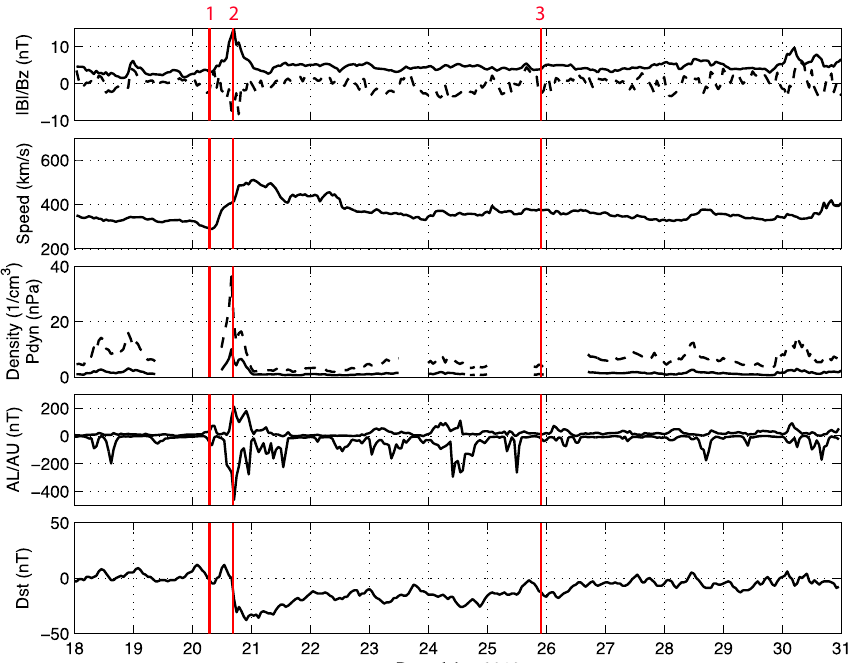
Fig. 1. Solar wind and global indices during 13 days of January 2010. Panels from top to bottom: IMF magnitude and IMF B Z component (dashed line), solar wind speed, dynamic pressure and number density (dashed line), AL/AU indices, and Dst index. Red vertical lines mark the substorm events examined in this study with the corresponding substorm number on the